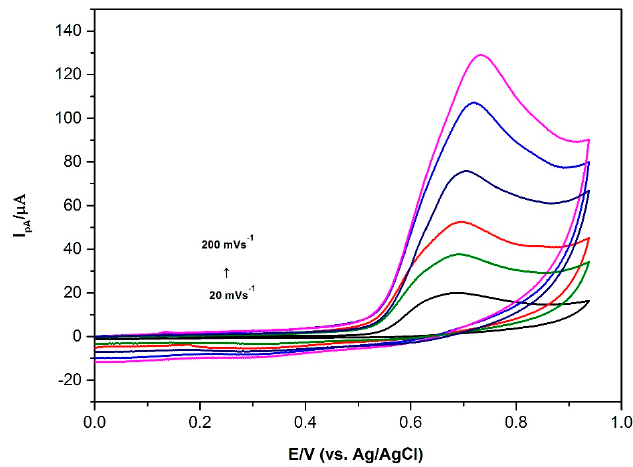
Figure 4. Cyclic voltammograms of 0.1 mM BPA at AuNP/PVP/PGE with different scan rates. Curve bottom to top is obtained at 20, 40, 60, 100, 150, 200 mVs − 1 , respectively. Conditions: pH 7.0 PBS; Ei: 0.00 V; Ef: 0.95 V.